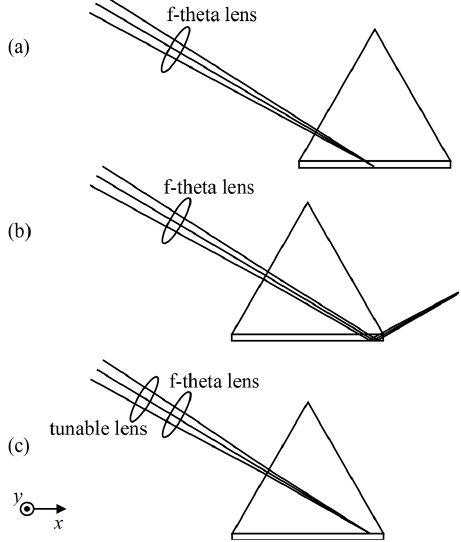
Figure 3. Schematic diagram showing the movement of the focal point of the illumination beam as the prism moves along the x-axis and the correction of the focal point achieved with an electronically tunable lens. ( a ) Illumination beam enters the prism and is focused on the back surface of glass slide; ( b ) As the prism moves towards the f-theta lens, the illumination beam is focused, but only after reflection from the back surface; ( c ) The tunable lens brings the focal point for the illumination beam back onto the back surface of the glass